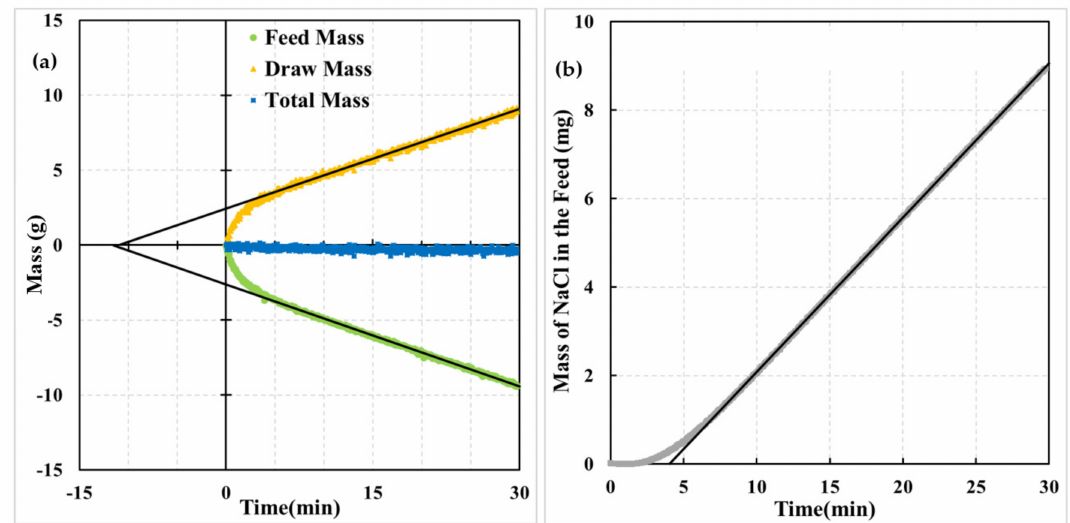
Figure 3. Progress of an experiment with the AL-DS membrane orientation; step change in the draw so-lution concentration of NaCl from 0 to 2 M; experiment carried out at 25 ± 0.3 ◦ C; ( a ) mass of the feed, draw, and feed + draw as a function of time; ( b ) mass on NaCl in feed solution as a function of time. Adapted with permission from Ref. [20]. 2020,